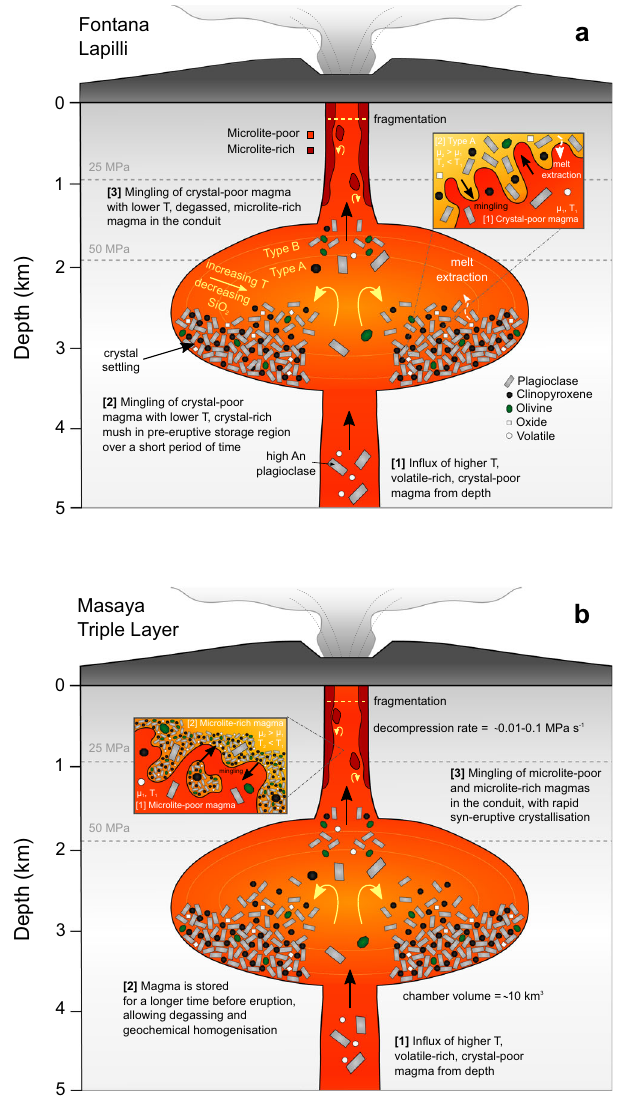
Fig. 6 A diagram illustrating the pre-eruptive condition of the FL and MTL eruptions of Las Sierras-Masaya volcanic system. For the ( a ) FL eruption, high-temperature (T), volatile-rich and crystal-poor magma from depth is injected into the shallow pre-eruptive reservoir, where it mingles with the lower temperature, crystal-rich mush in the storage region for a short period before eruption. Temperature contrast and crystal content is highest at the reservoir margin in contact with cooler host rock. Mush forming phases settle and accumulate along the reservoir fl oor. Convection transfers heat and mass within the reservoir. For the ( b ) MTL eruption, new magma injected from depth is stored for a longer period, allowing degassing and geochemical homogenisation within the storage region. This microlite- poor magma then mingles with the microlite-rich magma within the conduit, ascending at high velocities, with rapid syn-eruptive crystallisation in minutes enabling magma fragmentation within the